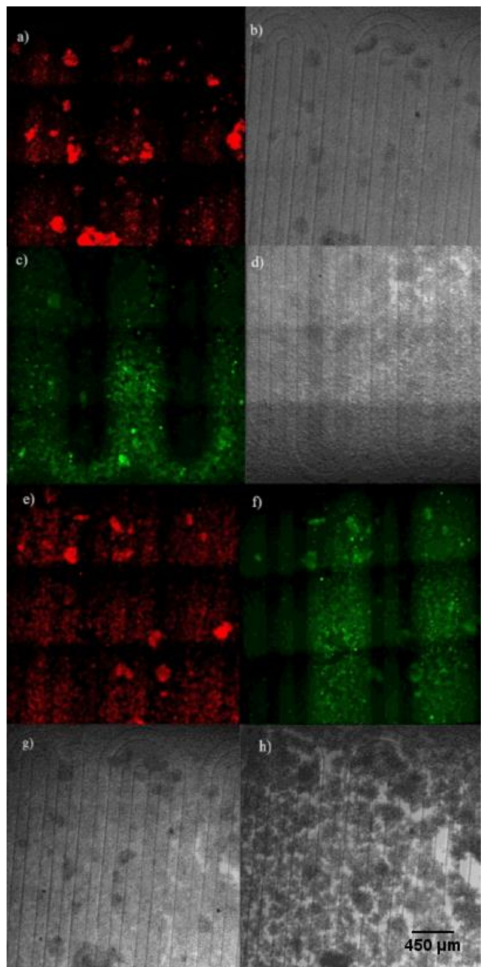
Figure 7. Combined patterning of hypoxia and nitric oxide microenvironment. ( a ) Hypoxia signal in the hypoxia only experiment. ( b ) Optical image of the cells in the hypoxia only experiment. ( c ) Nitric oxide signal in the nitric oxide only experiment. ( d ) Optical image of the cells in the nitric oxide only experiment. ( e ) Hypoxia signal in the combined experiment. ( f ) Nitric oxide signal in the combined experiment. ( g ) Phase contrast image of the cells before the simultaneous hypoxia and nitric oxide experiment. ( h ) Phase contrast image of the cells after the simultaneous hypoxia and nitric oxide experiment (image magnification: 100 ×